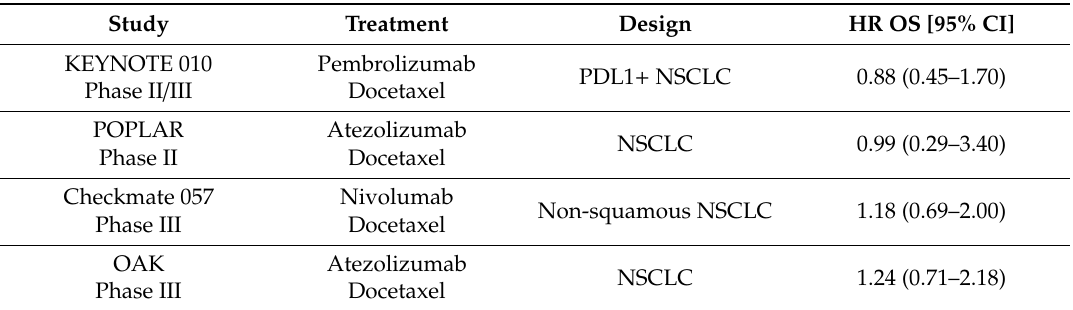
Table 2. Subgroup analyses of epidermal growth factor receptor (EGFR + ) and anaplastic lymphoma kinase (ALK + ) patients in large randomized control trials with immune checkpoint inhibitors.